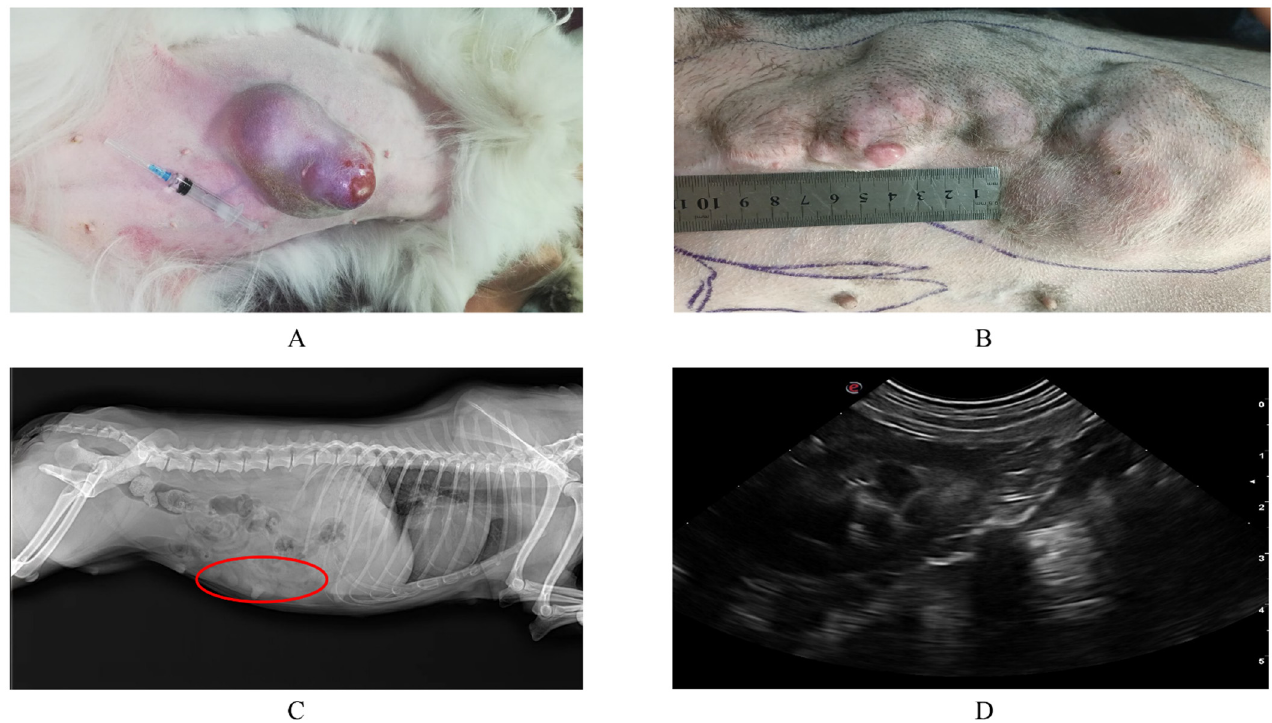
Figure 1. Clinical examination of canine mammary tumors. ( A , B ) are clinical observation pictures of canine mammary tumor diseases; the affected dogs were observed to have a distinct mass in the thorax, irregular in shape and sliding on palpation. Tumors were breakable, bleeding and ulceration during growth. ( C ) is a lateral view of the X-ray, the circle where a mass with slightly stronger density than the surrounding tissue is seen, soft tissue opacity structures were observed along the bilateral peripheral abdomen, with no obvious metastasis of the tumor. ( D ) is an ultrasonography examination with normal organ echo, and without abdominal metastases